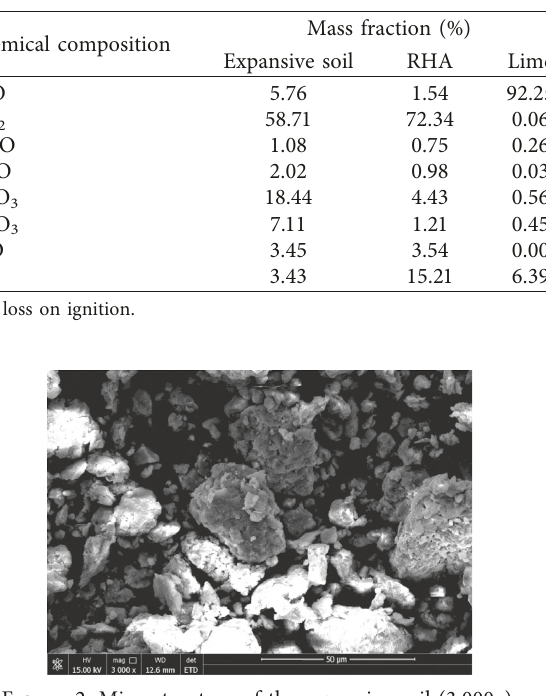
Figure 1: Particle size of expansive soil. Table 2: Composition of materials.